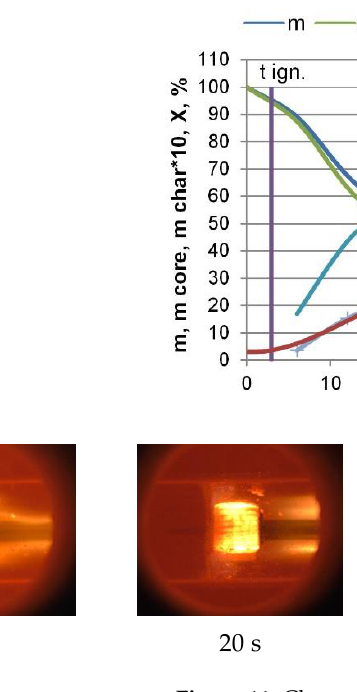
Figure 11. Characteristics of two-stage combustion of wood particles in the channel at T furnace of 800 °C and air velocity of 20 m s −1 : m —mass of the charred particle, m core —mass of particle wood core, m char —mass of the char layer, X —degree of overlapping of stages; t ign. —average time of particle ignition start, s; T c —temperature of sample center, °C.